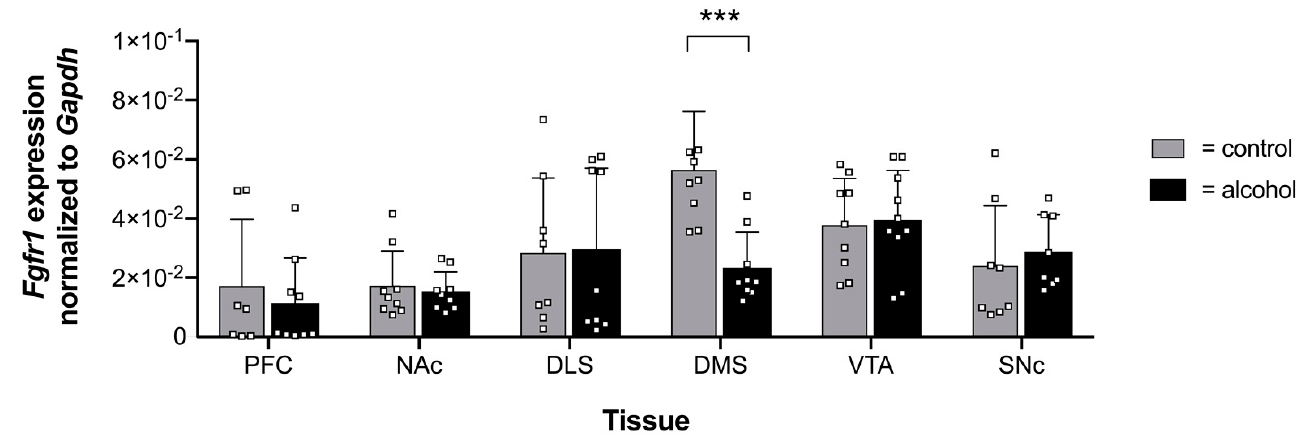
Figure 4. Expression and unified analysis of Fgfr1 . Expression profiles of the Fgfr1 gene in six murine brain areas. Fgfr1 expression was significantly decreased in the dorsomedial striatum (DMS) of mice consuming 20% alcohol for a six-week period compared with the control mice. Data are presented as mean ± SEM with squares depicted as individual data points (n = 7–10 biological replicates) analyzed with Student’s paired t -test, *** p ≤ 0.001.